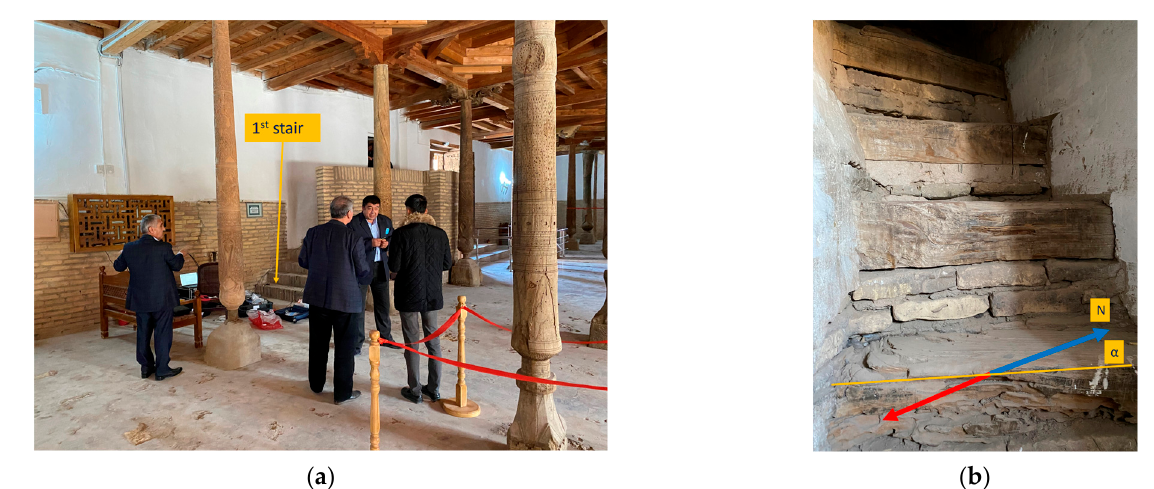
Figure 7. Starting stair and the procedure for the angle measurement of each stair: ( a ) view of the first stair; ( b ) schematic of the angle measurement.